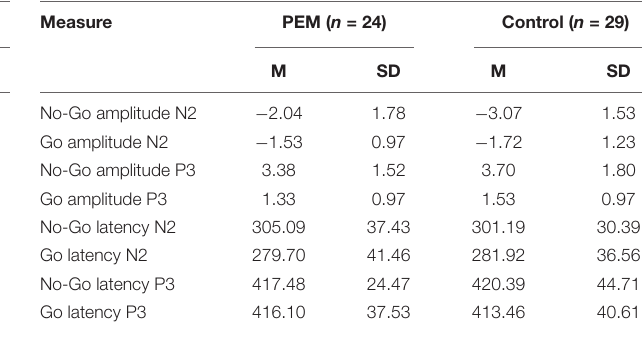
TABLE 3 | Mean and standard deviation of the evoked-related potentials (ERP) measures for Fz electrode. TABLE 4 | Mean and standard deviation of the ERP measures for FCz